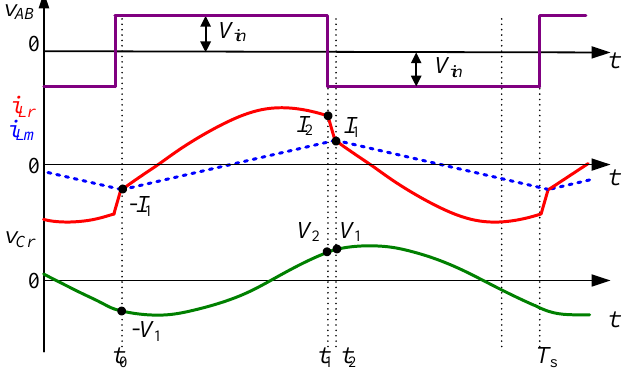
Figure 6. PSIM simulation results of the state-trajectories at resonant frequency.